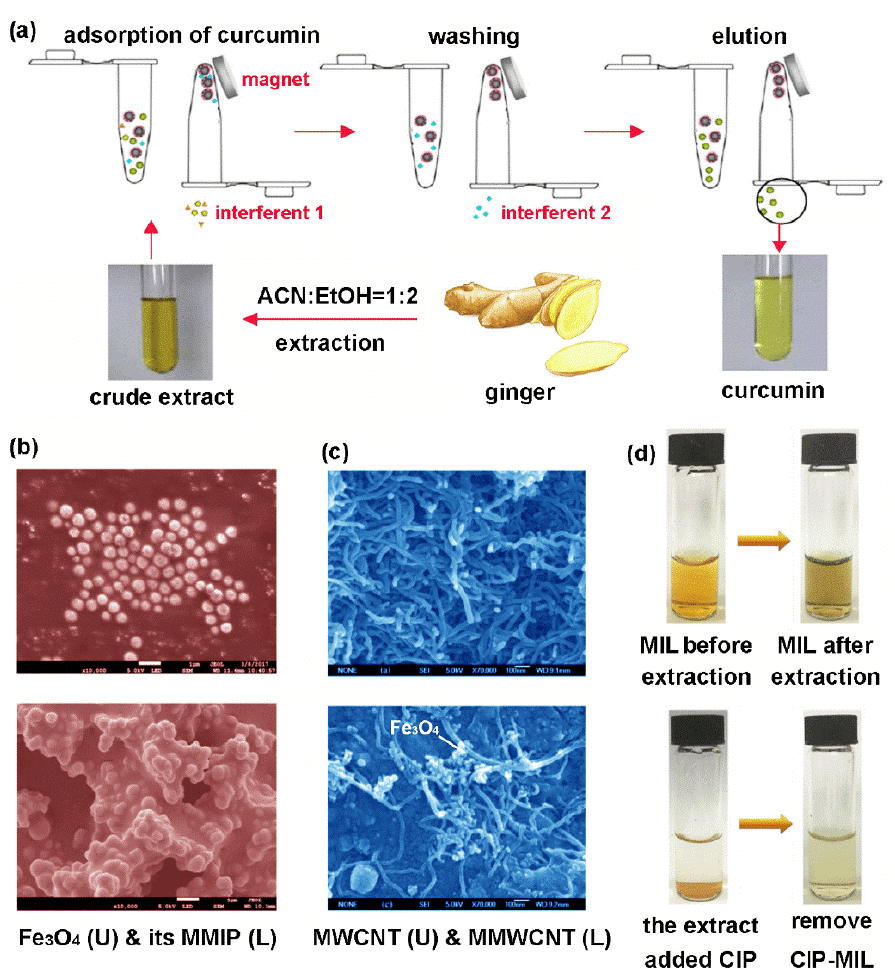
Figure 4. ( a ) The extraction process of curcumin from ginger by magnetic solid-phase extraction; ( b ) SEM images of Fe 3 O 4 and its MMIP [109]; ( c ) MWCUT and MMWCNT [110]; ( d ) separation of TPs by MIL and CIP [43].